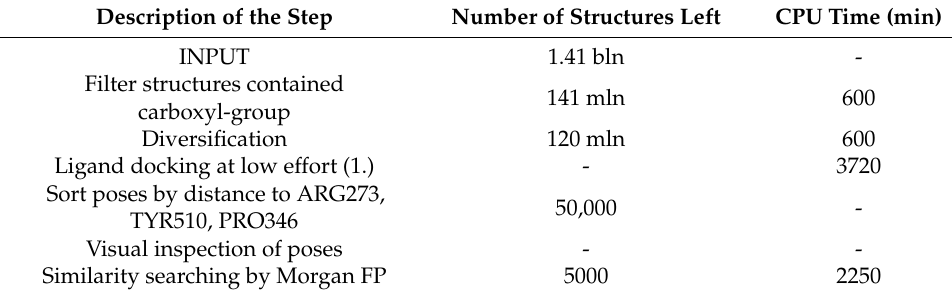
Table 4. Optimal roadmap